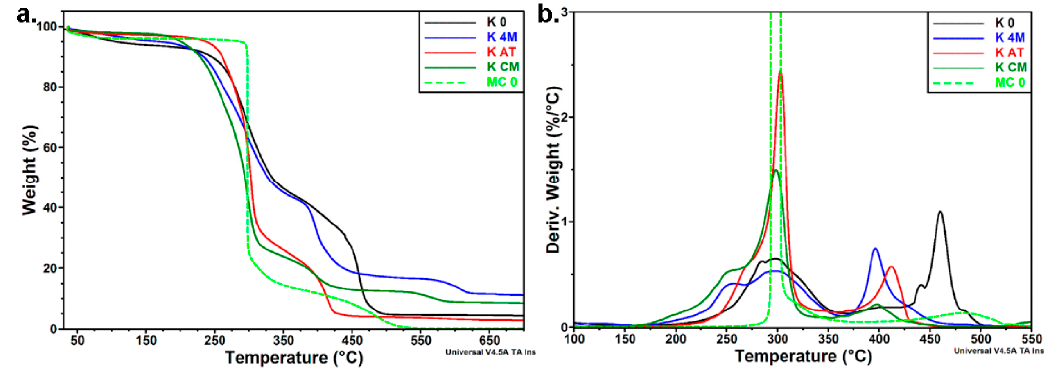
Figure 11. High-Res TGA ( a ) and DTG ( b ) curves of Kombucha pellicles.